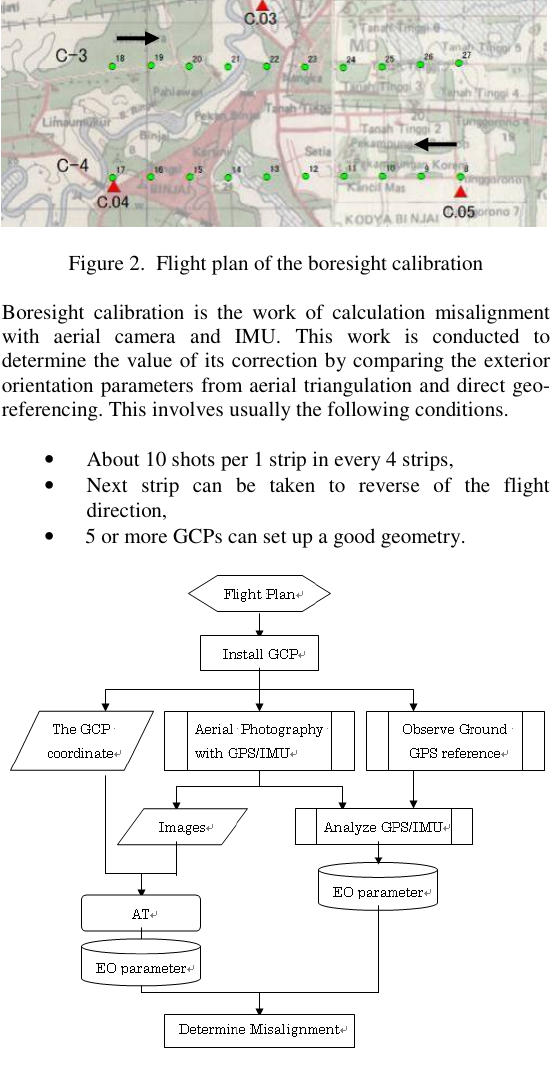
Figure 3. Work Flow for the boresight